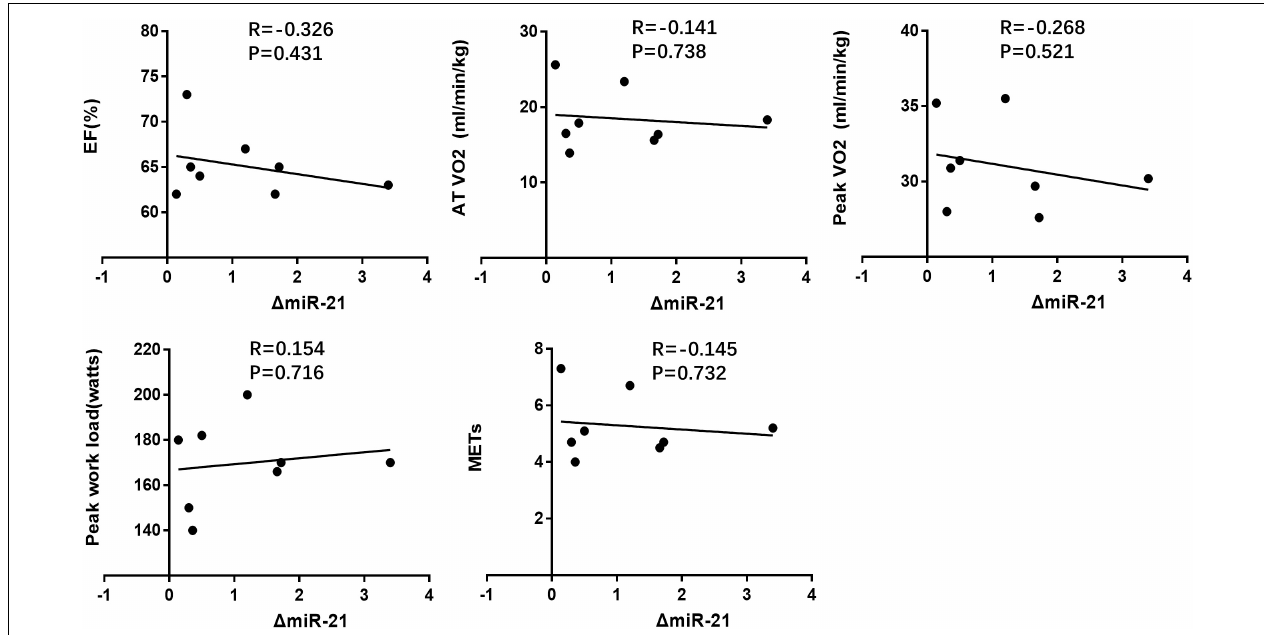
FIGURE 4 | Correlation analysis between the changes of miR-21 following AET and cardiac function (EF%), exercise capacity (AT VO 2 , peak VO 2 , peak work load, METs) at baseline.